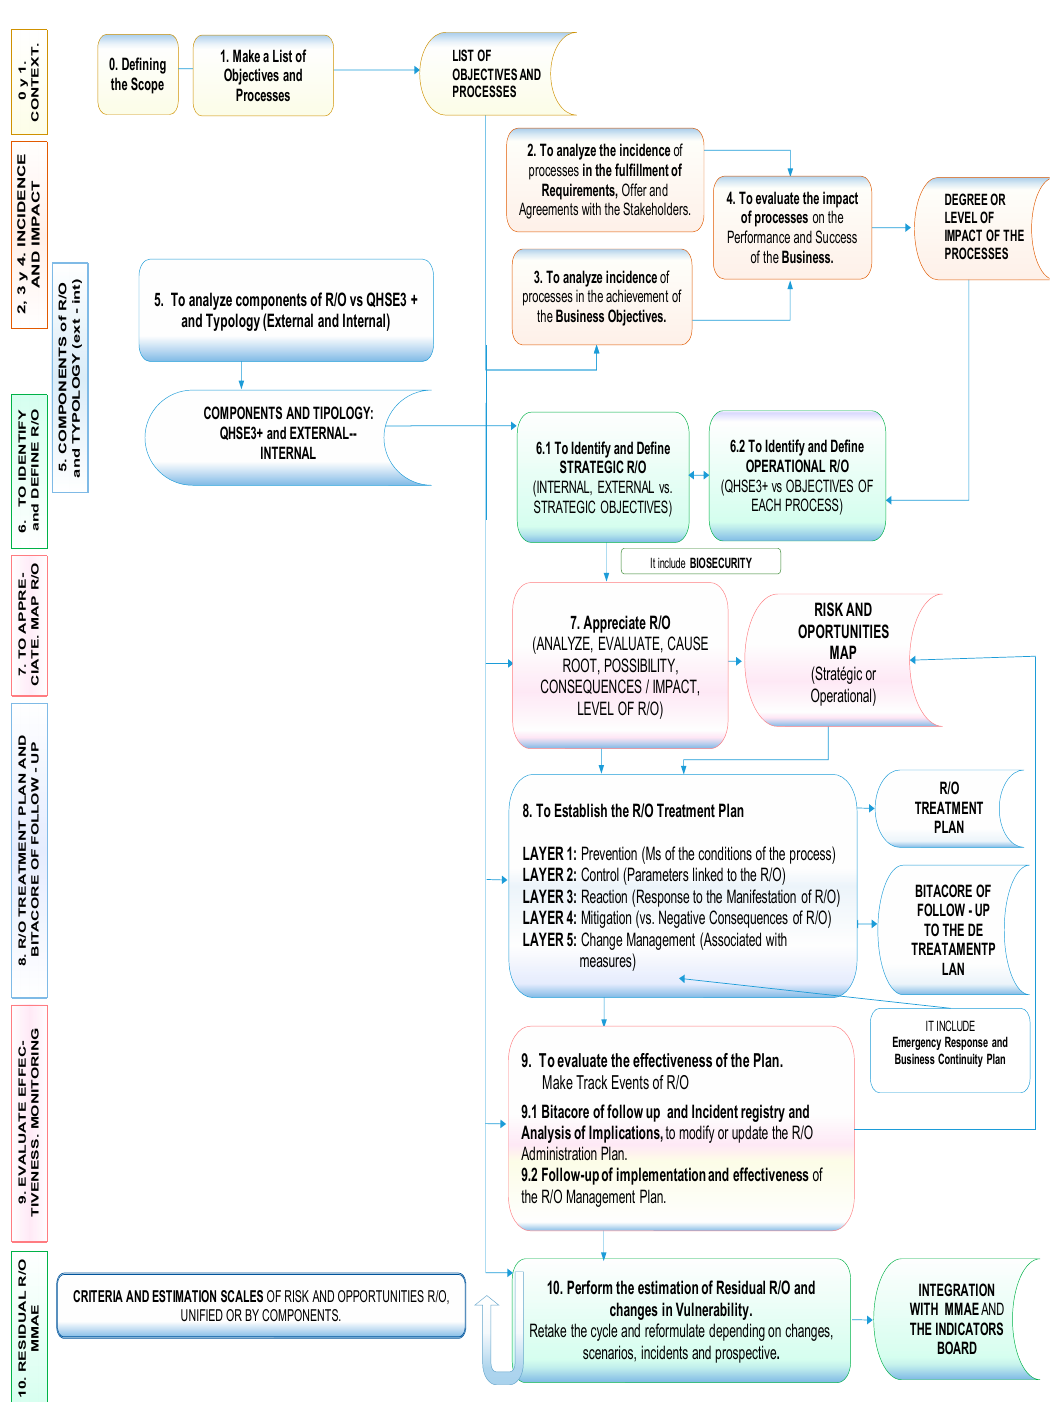
CRITERIA AND ESTIMATION SCALES OF RISK AND OPPORTUNITIES R/O, UNIFIED OR BY COMPONENTS.